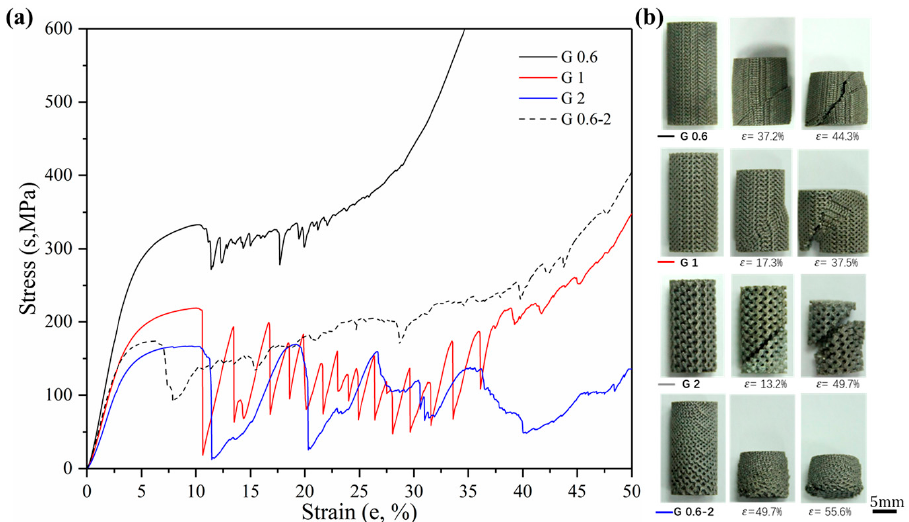
Figure 9. ( a ) Compressive stress-strain curves of Gyroid gradient in cell-size ranging from 0.6 to 2 mm, and ( b ) video frames at the corresponding strain from the compression.